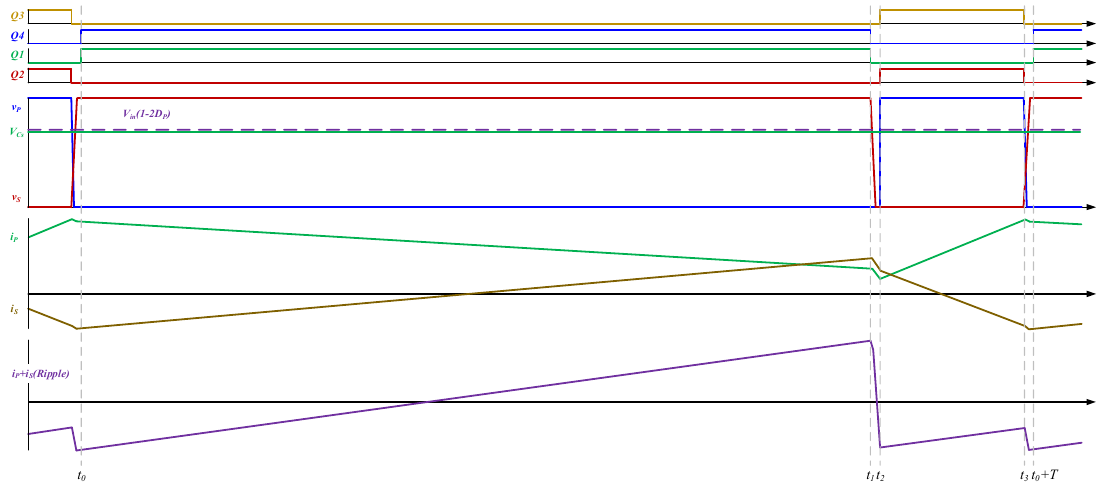
Figure 15. Operation sequence diagram of a stacked buck converter with conventional dead time.